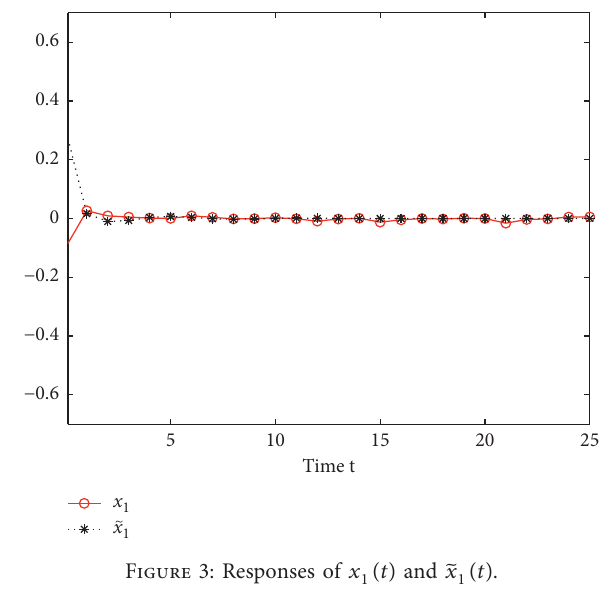
Figure 3: Responses of x